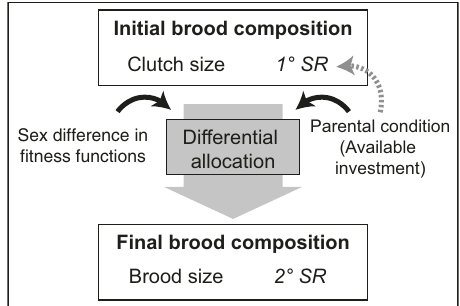
Fig. 1 Schematics illustrating links between the components of the multi- element parental strategy. Primary sex ratio ( 1° SR ), clutch size, brood size, parental investment rules of differential allocation between sexes, and the resulting secondary sex ratio ( 2° SR ), including two factors (parental condition/available investment and sex difference in fi tness functions) that affect the optimal parental strategy are shown. The globally optimal strategy assumes the ability of parents to modify the primary sex ratio according to the parental investment, while the locally optimal strategy does